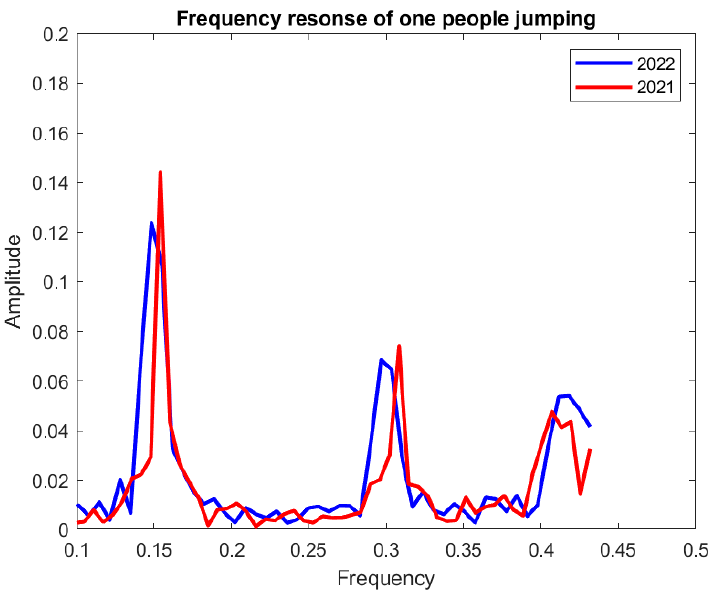
Figure 8. Comparison of two years’ sensor response for one person jumping.